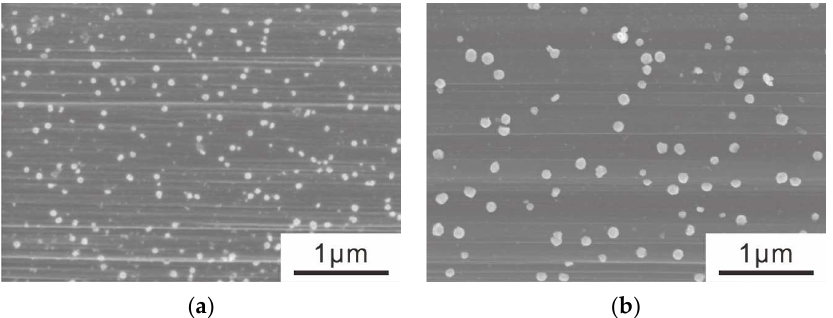
Figure 5. Enlarged FE-SEM images of ( a ) D-Ni-CF ( I = 200 mA, J = 3.79 A/m 2 , t = 5 s) and ( b ) P-Ni-CF ( I = 200 mA, J = 3.79 A/m 2 , t ON = 10 ms, t OFF = 100 ms, t = 5 s).